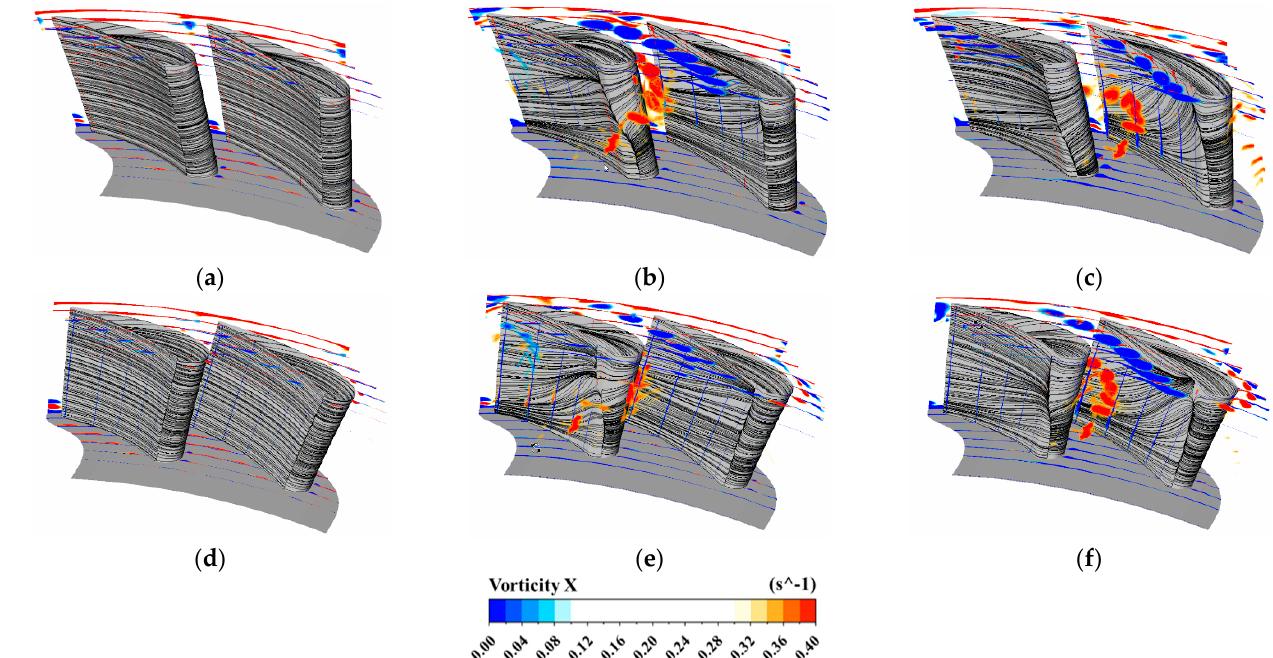
Figure 21. Swirl clocking interaction with passage flow − the influence of straight lean angle: ( a ) SL12 SP0 No swirl; ( b ) SL12 SP0 SW@LE; ( c ) SL12 SP0 SW@PC; ( d ) SL − 12 SP0 No swirl; ( e ) SL − 12 SP0 SW@LE; ( f ) SL − 12 SP0 SW@PC.